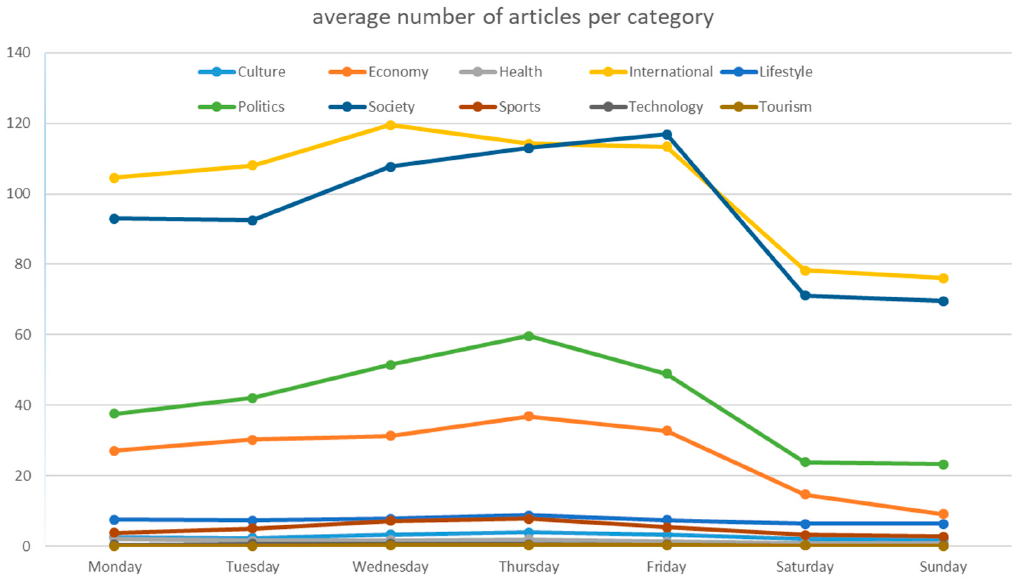
Figure 7. Average number of articles per category/day.